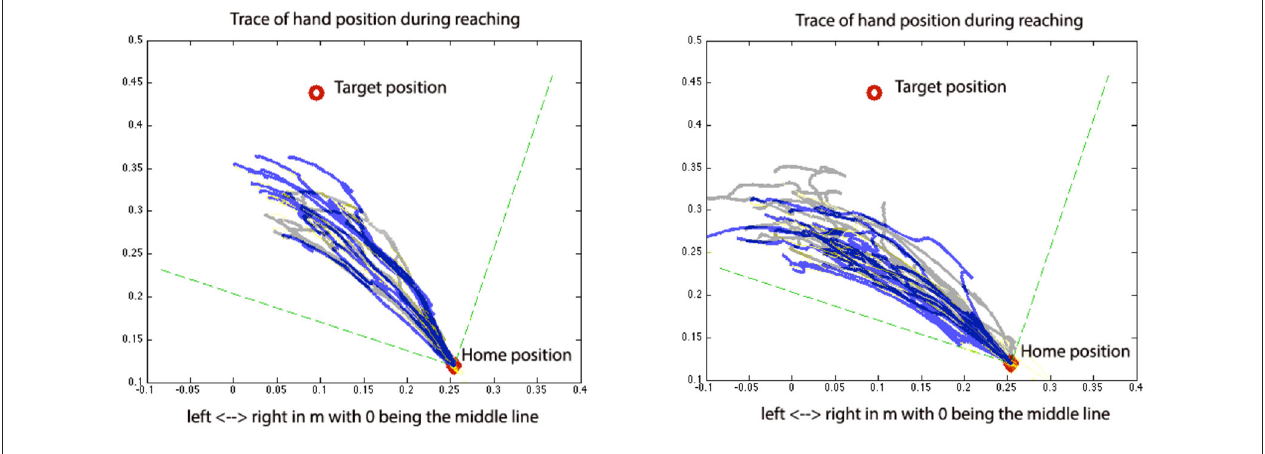
the MVT shoulder load (right) . In this figure, the gray and blue traces represent the traces of hand position pre- and post-tDCS, respectively.